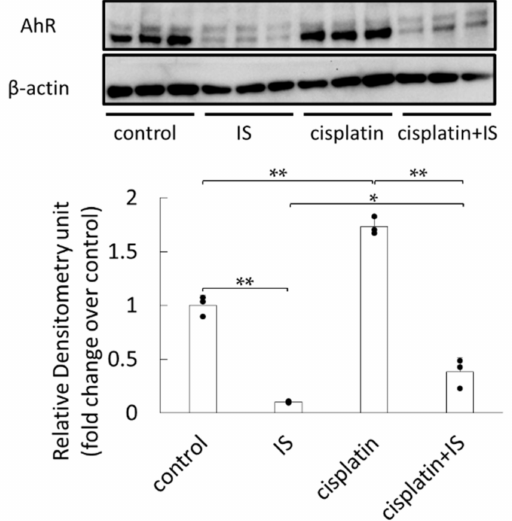
Figure 7. Effect of treatment with cisplatin and/or IS on AhR expression in HK-2 cells: each column represents the mean ± SD of triplicate samples. * p < 0.05; ** p < 0.01.